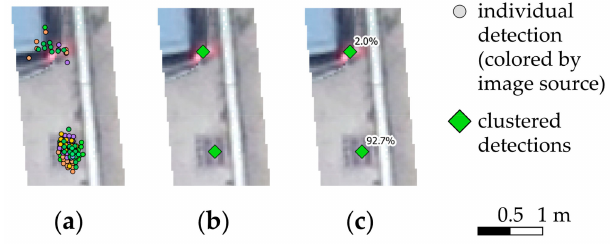
Figure 4. ( a ) The combined detections from all ten images in which the sewer inlet was detected, forming an obvious cluster around the object; ( b ) Cluster centers identified from the combined detections; ( c ) Cluster centers with associated confidence scores, as computed by the cluster